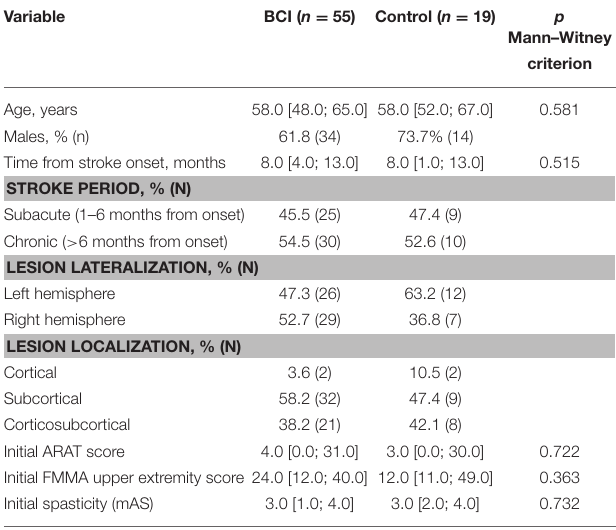
TABLE 1 | Demographics and main baseline characteristics of subjects by study